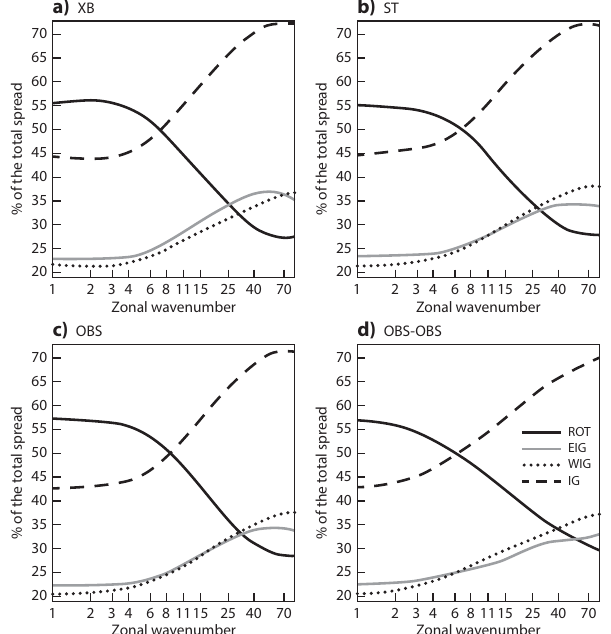
Figure 7. Time-averaged ensemble spread in the balanced and inertio-gravity modes for (a) XB-EDA , (b) ST-EDA , (c) OBS - and (d) OBS-OBS EDA . Black curves correspond to the spread associ- ated with balanced modes (ROT), grey curves to spread due to east- erly propagating inertia-gravity (EIG) modes whereas dotted curves represent spread due to westerly propagating inertia-gravity modes (WIG).